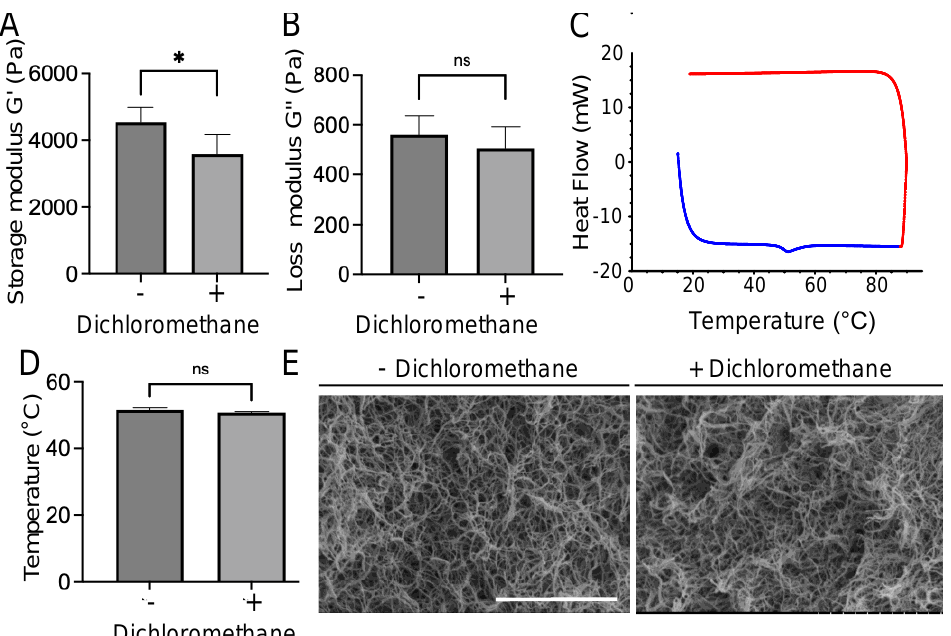
Figure 4. Mechanical and structural characterization of collagen gels before and after dichloromethane treatment. ( A ) Storage modulus and ( B ) loss modulus measured by rheology. (C) Denaturation curve for the sample treated with dichloromethane. The blue curve represents the thermal exchange during the temperature rise, whereas the red curve corresponds to the decrease in temperature. Only one denaturation peak is visible at 55 °C. ( D ) Temperature of denaturation peak of collagen fibrils measured by differential scanning calorimetry (DSC). ( E ) SEM images of collagen fibrils without (−) and with ( + ) a dichloromethane bath. Scale bar: 5 µm. * corresponds to p < 0.05, ns p > 0.05.